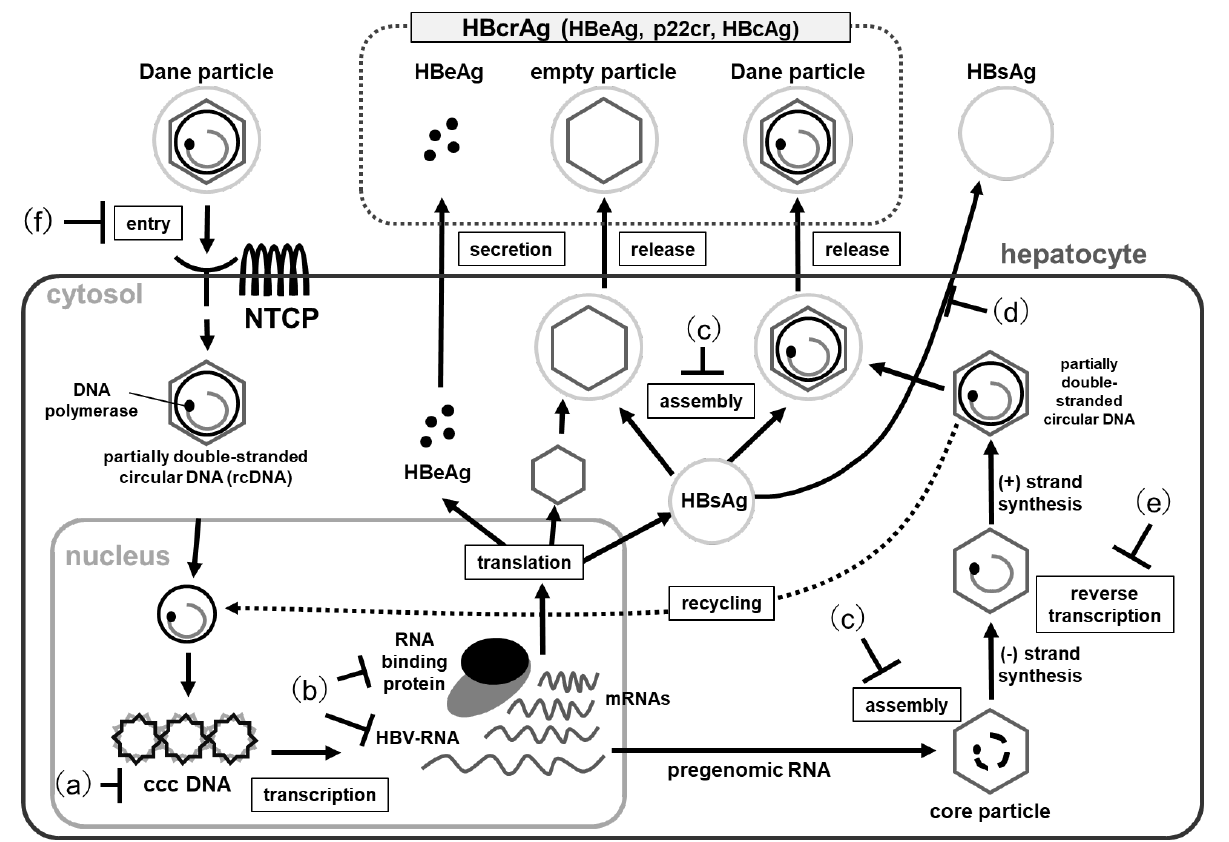
Figure 1. Replication cycle of HBV and steps targeted by therapeutic agents (DAAs). ( a ) Targeting cccDNA, ( b ) Targeting viral RNA or HBV RNA binding protein, ( c ) Inhibition of capsid formation or nucleocapsid assembly, ( d ) HBsAg Inhibitors, ( e ) Inhibition of reverse transcription. ( f ) Inhibition of HBV entry into hepatocytes. Table 1. Novel HBV therapeutic agents targeting HBV directly or indirectly, currently in phase II and beyond.